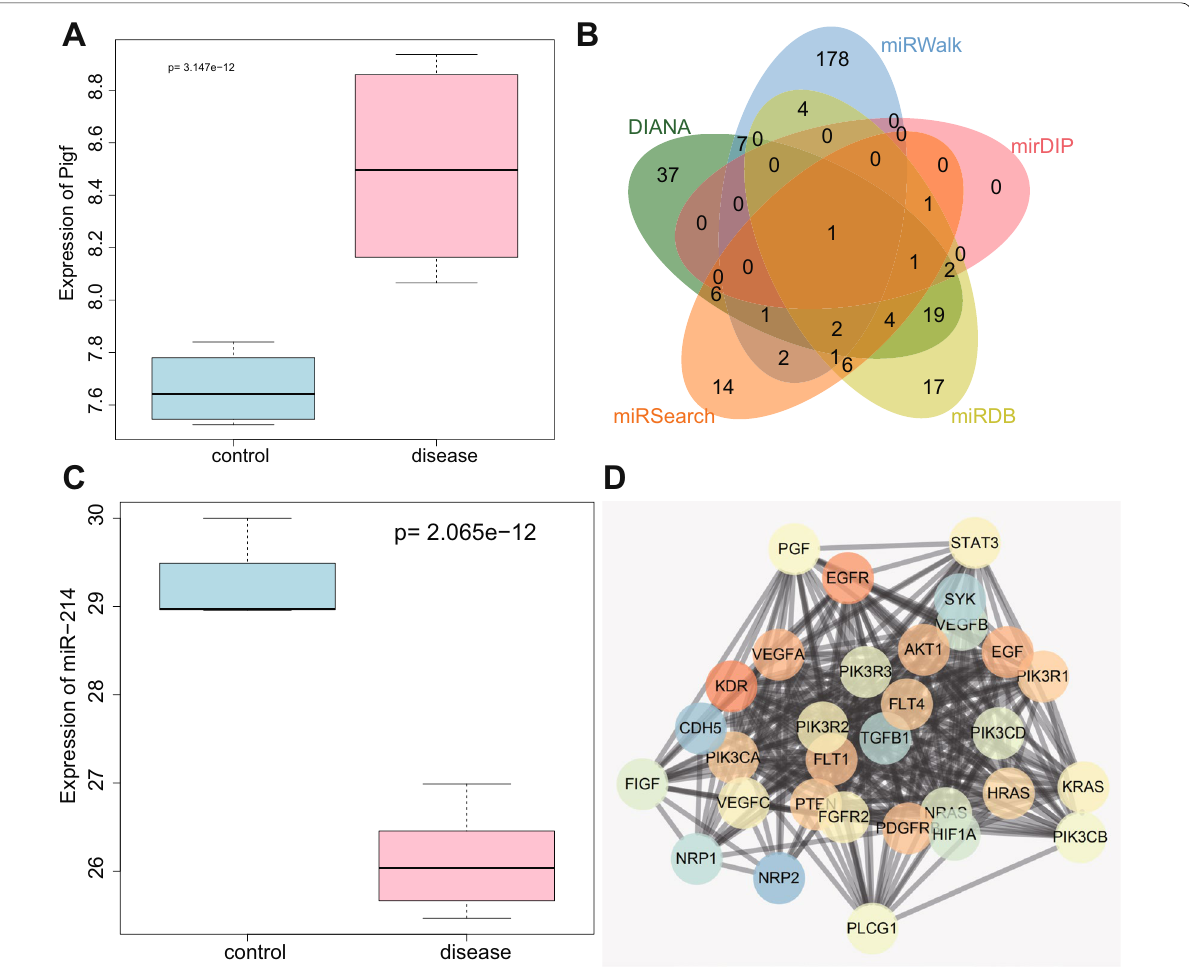
Fig. 1 The PlGF/miR‑214/STAT3 axis is predicted to be involved in BPD. A PlGF expression in the GSE25293‑GPL1261 dataset; the blue box on the left indicates the expression level in normal samples, and the red box on the right indicates the expression level in BPD samples. B The Venn diagram depicting the intersection of upstream miRNAs of PlGF predicted by the DIANA Tools, miRWalk, mirDIP, miRDB, and miRSearch databases. C A box plot depicting miR‑214 expression in the GSE25293‑GPL11199 dataset; the blue box on the left indicates the expression in normal samples, and the red box on the right indicates the expression in BPD samples. D PPI network analysis of PlGF (PGF); darker hue of the red gene sphere indicates greater importance and darker hue of blue gene sphere indicates lower